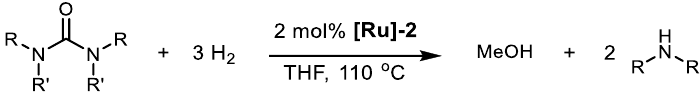
Figure 11. Hydrogenation of urea using a ruthenium pincer catalyst.